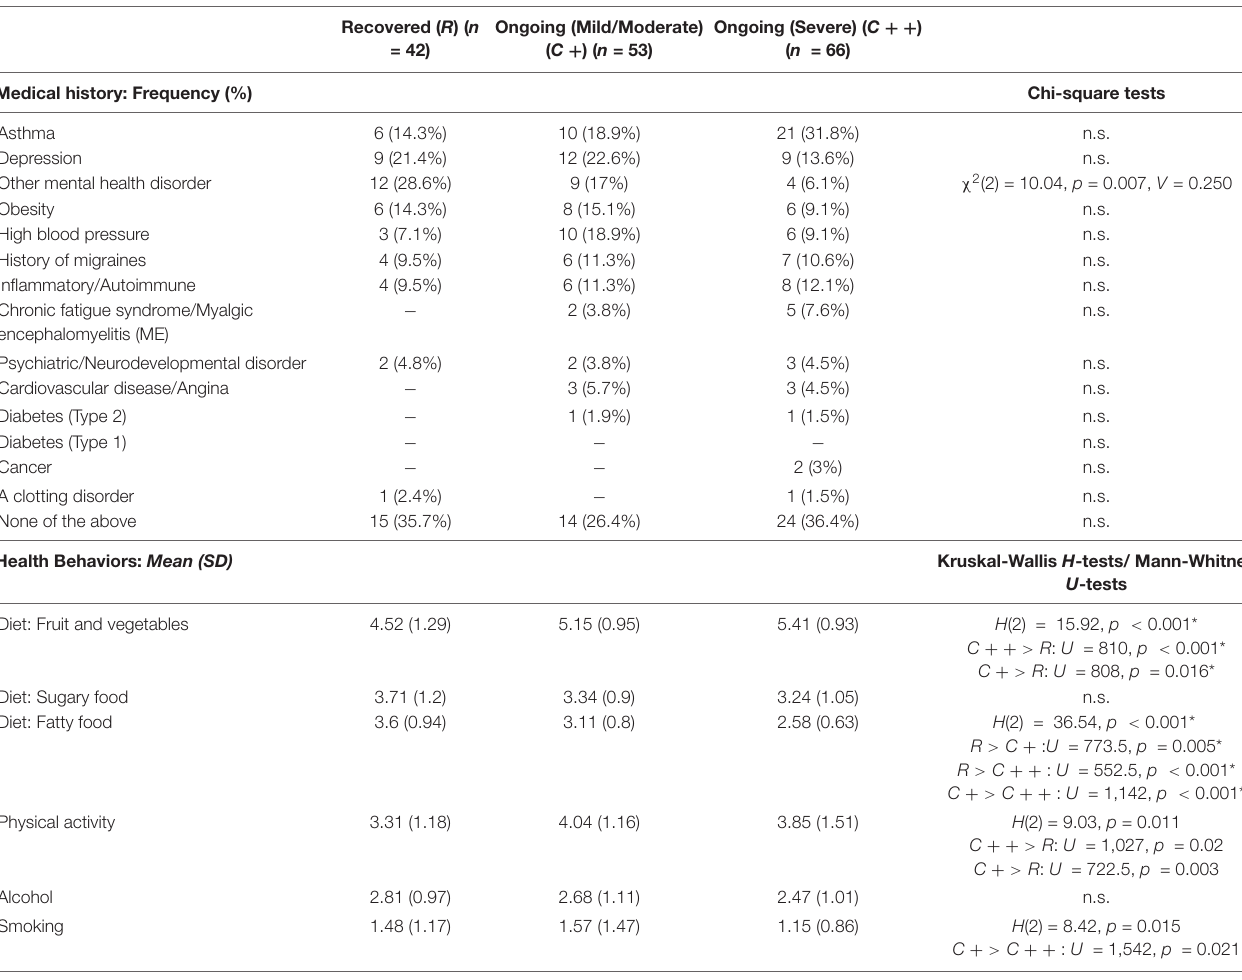
TABLE 2 | Distribution of medical history and health behaviors (1 = Never–6 = Several times daily; higher scores indicating higher frequency) in COVID subgroups: Recovered (R), Ongoing (Mild/Moderate) (C+) and Ongoing (Severe) (C++). Recovered ( R ) ( n Ongoing (Mild/Moderate) = 42) ( C + ) ( n =